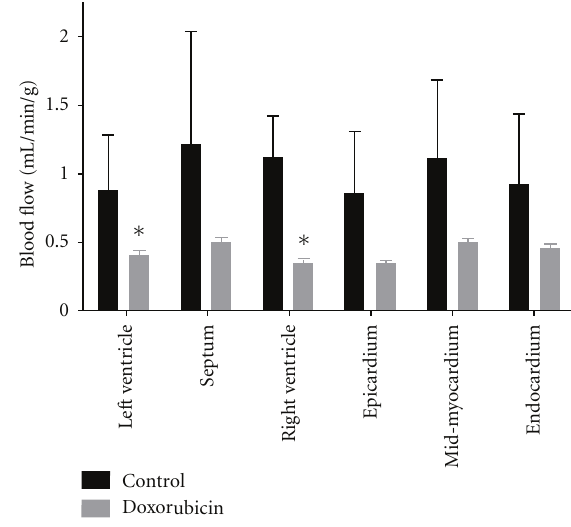
Figure 2: Regional myocardial blood flow was determined with 15 μ m microspheres in control and doxorubicin-treated animals. ∗ P < 0 . 05 versus control; n =